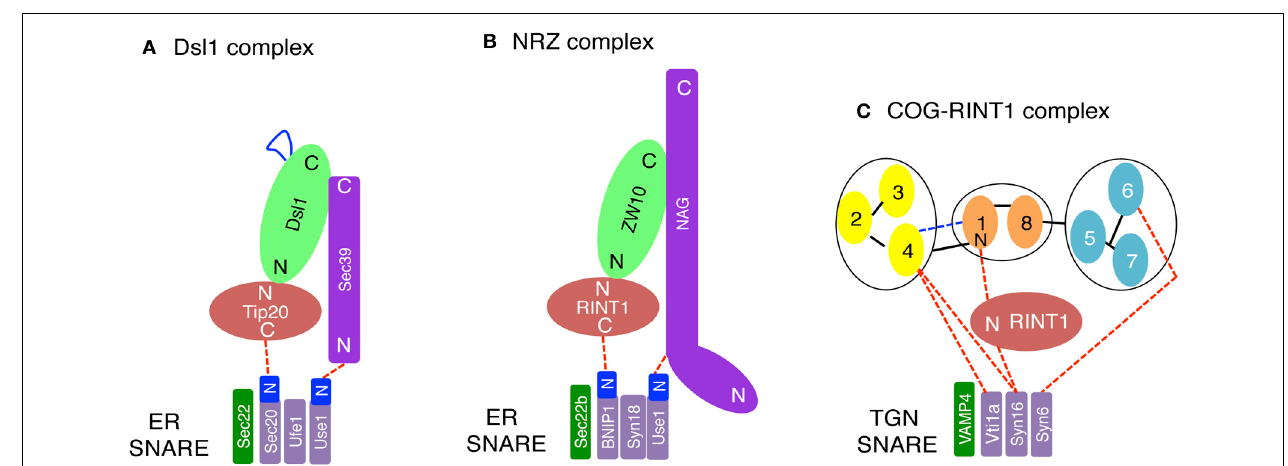
FIGURE 2 | Interactions between tethers and SNAREs. (A) On yeast ER membranes, Tip20 and Sec39 bind to the N-terminal regions (N) of Sec20 and Use1/Slt1, respectively. The region of Dsl1 shown in blue represents an acidic region that interacts with COPI components. (B) On the mammalian ER, RINT1 and NAG bind to the N-terminal regions